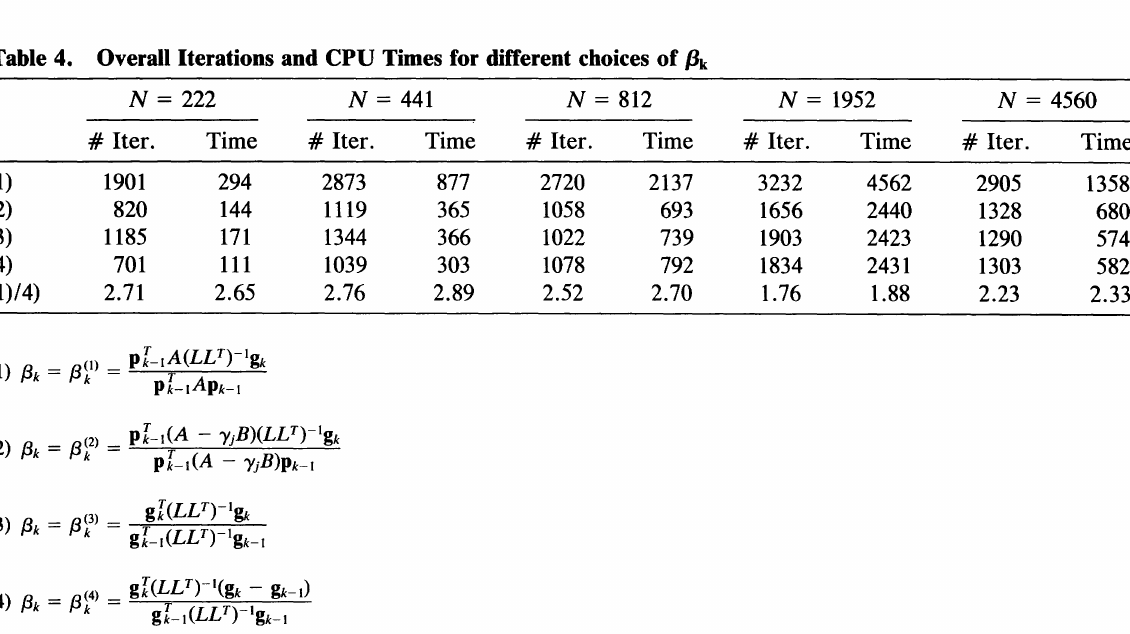
Overall Iterations and CPU Times for different choices of p,. N = 222 N = 441 N = 812 N = 1952 N = 4560 #